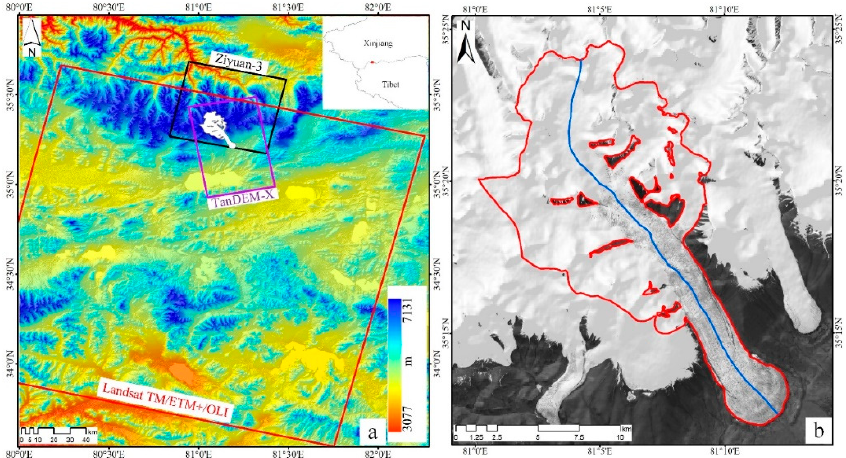
Figure 1. The geographic location of the study area. The coverages of the TanDEM-X, ZiYuan-3, and Landsat TM/ETM+/OLI data are shown as purple, black, and red triangles, respectively, in ( a ). The inset picture in ( a ) shows the general location of the Chongce Glacier, and the red area in the inset map indicates the position of the study area. The background in ( b ) is the Landsat ETM+ image acquired on 3 July 2002, with the red and blue lines respectively marking the outlines and the centerline of the Chongce Glacier, which were acquired from the Second Chinese Glacier Inventory [27].